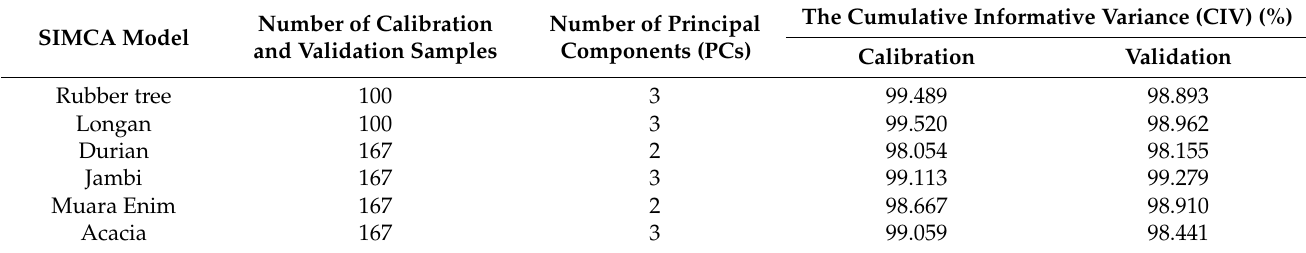
Table 2. The result of SIMCA (soft independent modeling of class analogy) model development for each class using calibration and validation sample sets.